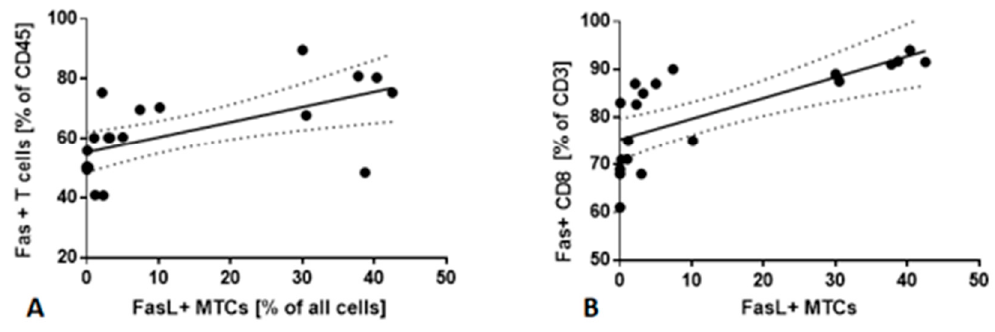
Figure 4. ( A ) The correlation between Fas + CD3 T cells and FasL + MTCs in LNs aspirates. ( B ) The Figure 4. A ) The correlation between Fas+ CD3 T cells and FasL+ MTCs in LNs aspirates. B ) The correlation between Fas + CD8 T cells in PB and FasL + MTCs in LNs correlation between Fas+ CD8 T cells in PB and FasL+ MTCs in LNs aspirates.